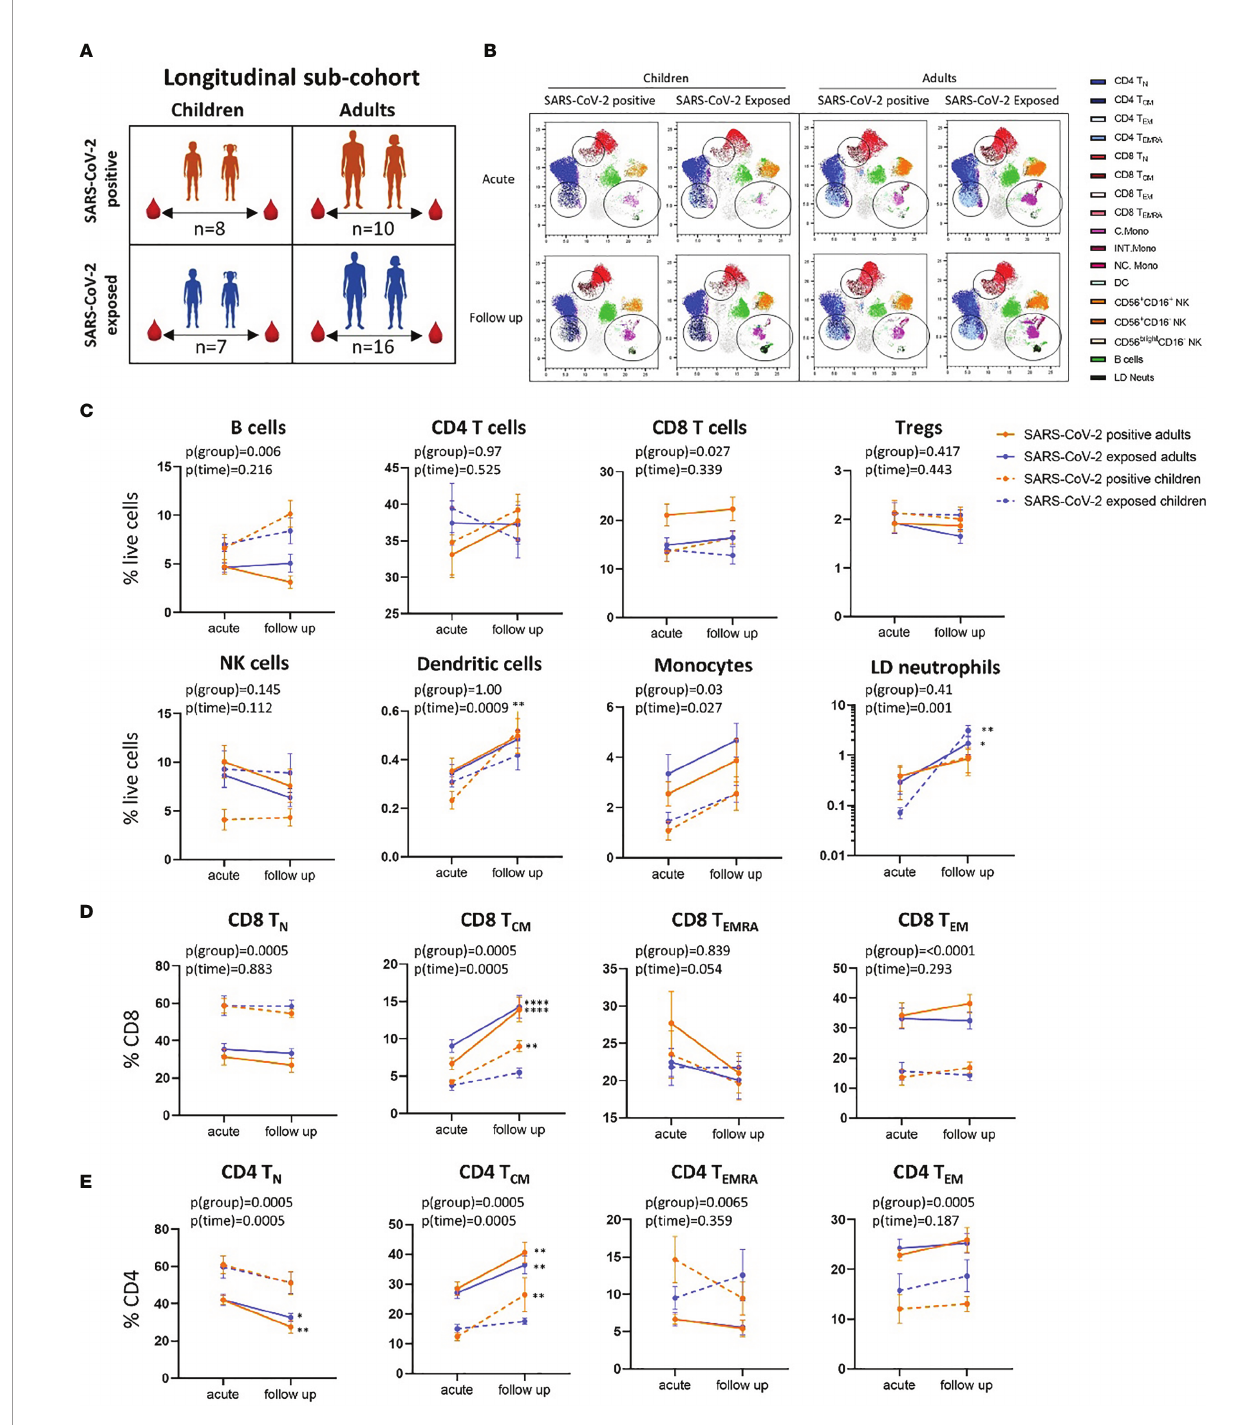
FIGURE 3 | Longitudinal analysis of immune cell pro fi les in SARS-CoV-2 positive and SARS-CoV-2 exposed children and adults. (A) Paired blood samples were collected during infection/exposure and 4-9 weeks following from n=8 SARS-CoV-2 positive children, n=10 SARS-CoV-2 positive adults, n=7 SARS-CoV-2 exposed children and n=16 SARS-CoV-2 exposed adults. (B) UMAP plots consisting of cells from each individual from each clinical group. Circles highlight changes in frequency over time in key cell clusters: monocytes, low density neutrophils, CD8 T CM and CD4 T CM subsets. (C) Longitudinal analysis of major immune cell proportions (by manual gating) in each clinical group. (D) CD8 and (E) CD4 T cell subsets in each clinical group. Naive T cells (T N ), central memory T cells (T CM ), effector T cells (T EMRA ) and effector memory T cells (T EM ). P-values by two-way repeated measures analysis of variance with Sidak ’ s multiple comparison testing. FDR-adjusted P-values are reported, *p < 0.05, **p < 0.01, ****p < 0.0001. For (C – E) , mean ± SEM are